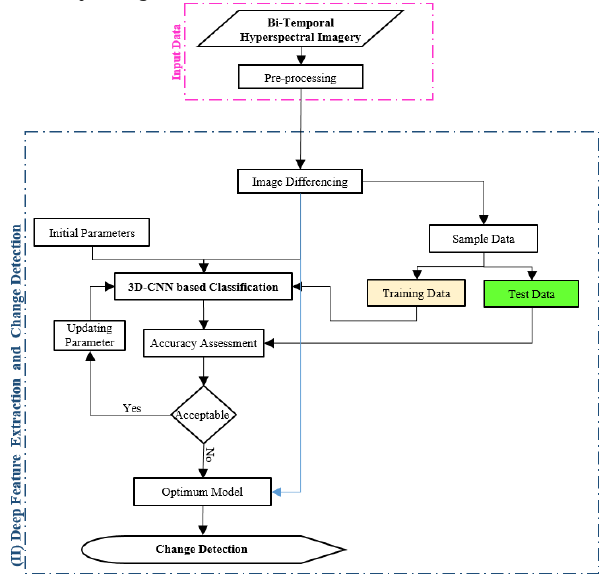
layers and two fully connected layers with no max-pooling layer.